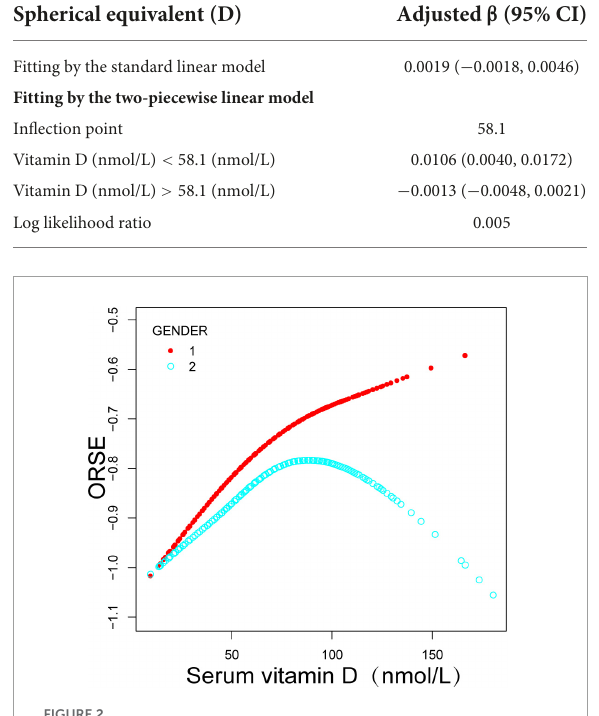
FIGURE2 Relationship between refractive status and serum vitamin D in adolescents, stratified by sex. Adjustments were made for covariates such as age, race, household income, education, body mass index, serum calcium, serum phosphorus and other covariates.